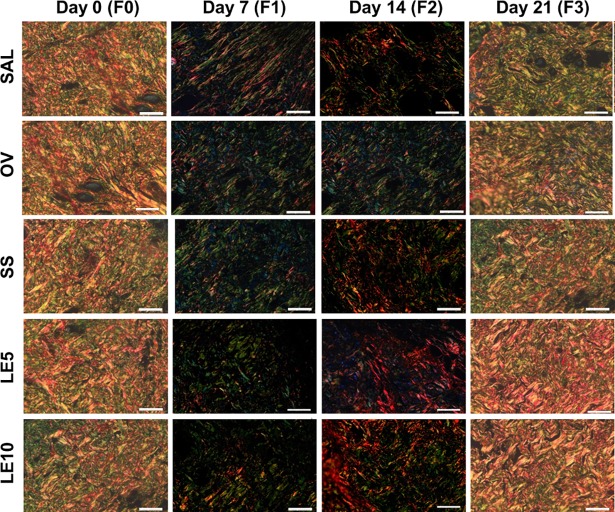
Representative photomicrographs obtained under polarizing microscopy demonstrate the distribution of collagen fibers in the scar tissue of rats treated with Strychnos pseudoquina ointment.Collagen fibers (type I) appear in shades of bright colors ranging from red to yellow, while thin reticular fibers (collagen type III) appear bright green. Tissue fragments were collected every 7 days during 21 days of treatment. Day 0 refers to the normal untreated tissue. Bar = 40 μm. Sirius red.